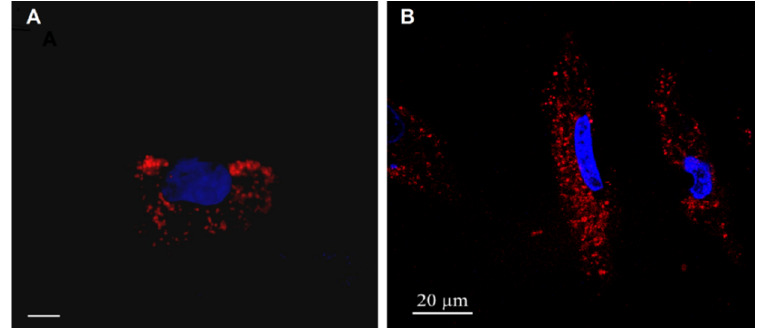
Figure 2. Internalization of Au NPs by HeLa cells. Images of HeLa cells incubated with fluorescence-labelled Au NPs. ( A ) Collagen-coated Au NPs; the scale bar corresponds to 10 µm. ( B ) PMA-coated Au NPs; the scale bar corresponds to 20 µm. The NPs were labelled with Dy TM 647 and, thus, appear in read. The nuclei were labelled with DAPI and, thus, appear in